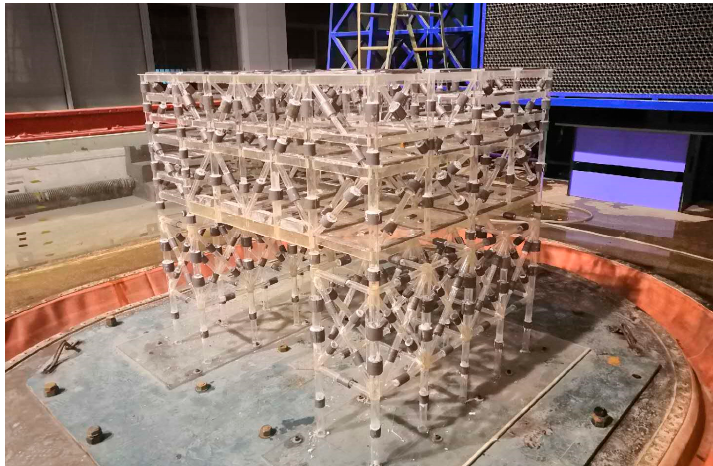
Table 4. Parameters of the earthquake simulating system.